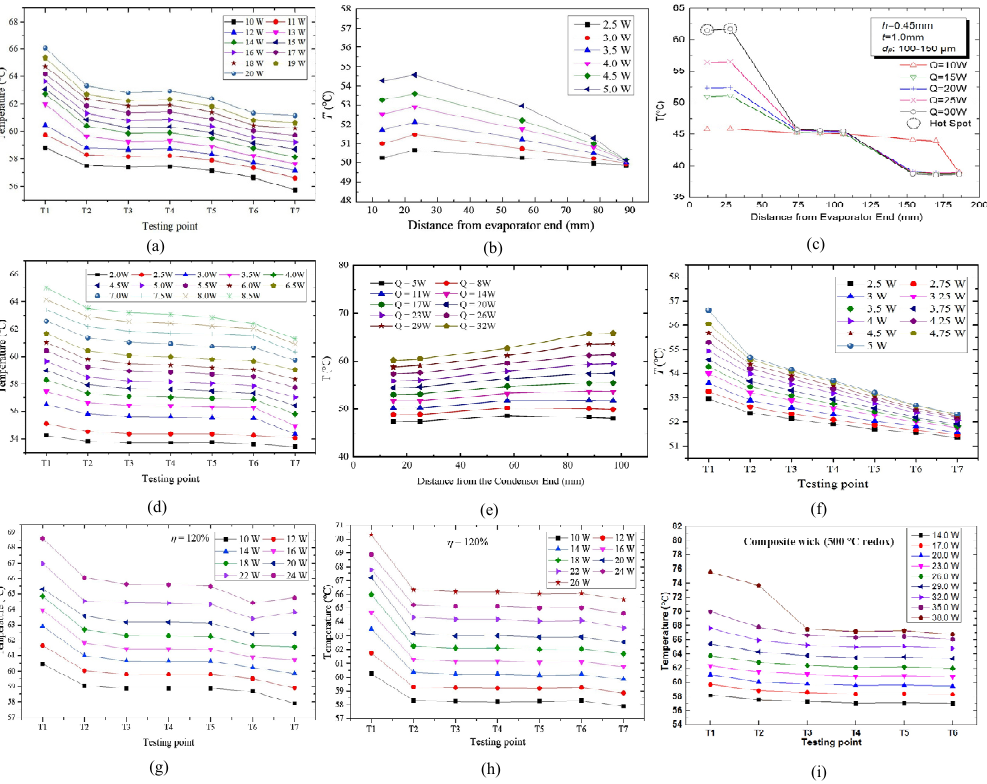
Figure 10. The temperature of each test point along the axial direction of the ultra-thin heat pipe of different literatures under different heating power, and the test points are uniformly distributed from the evaporation end to the condensation end of the heat pipe: ( a ) [18], ( d ) [55], ( f ) [11], ( g ) [41], ( h ) [41], ( i ) [56]; the test points are distributed along the distance from the evaporation end to the condensation end of the heat pipe: ( b ) [45], ( c ) [48], ( e ) [40].